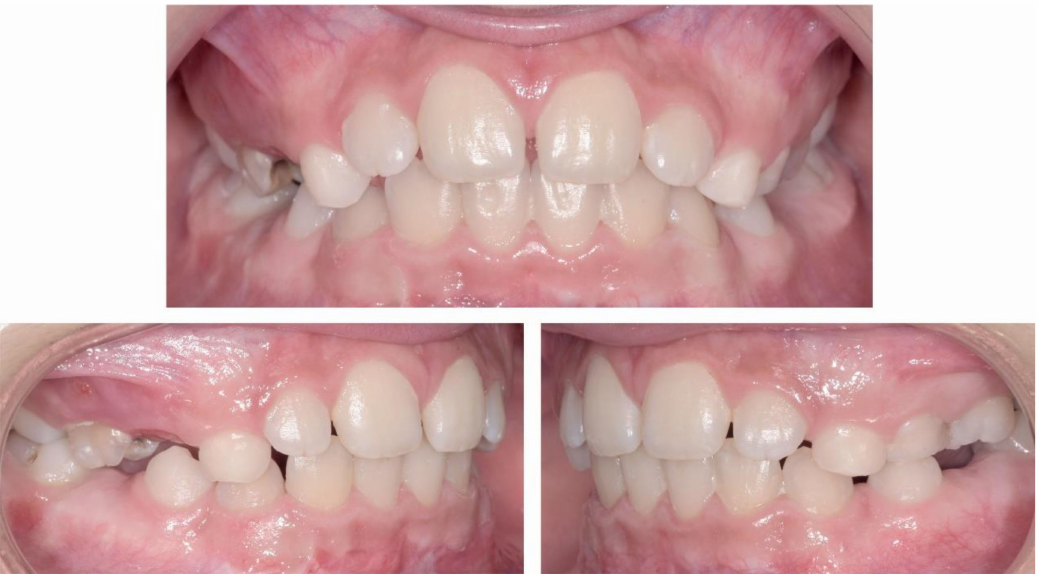
Figure 5. Pre-treatment intra-oral photographs.